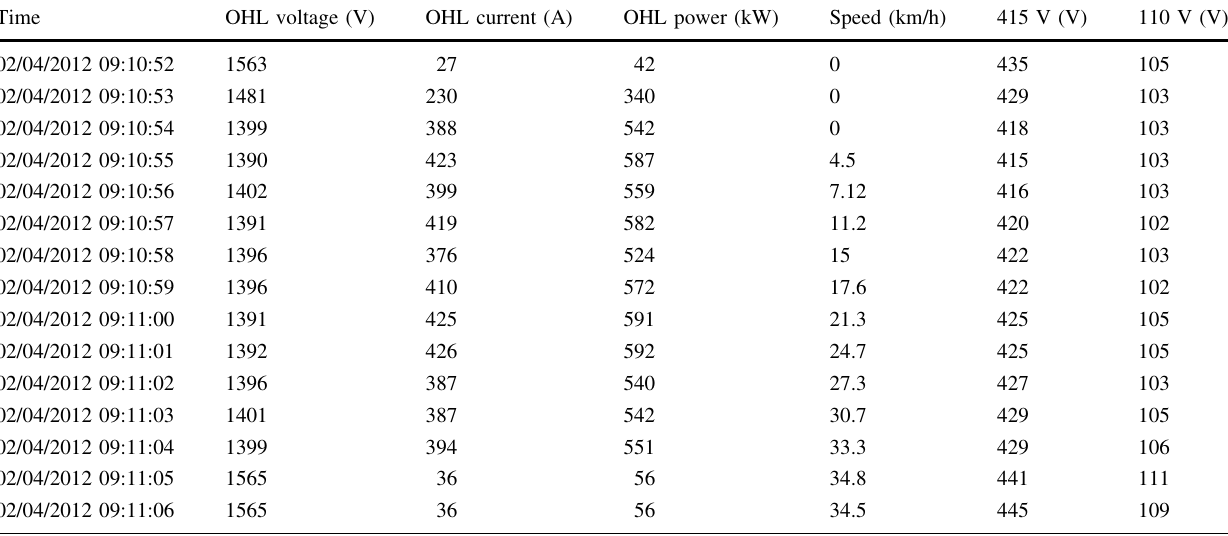
Table 1 Example of raw data